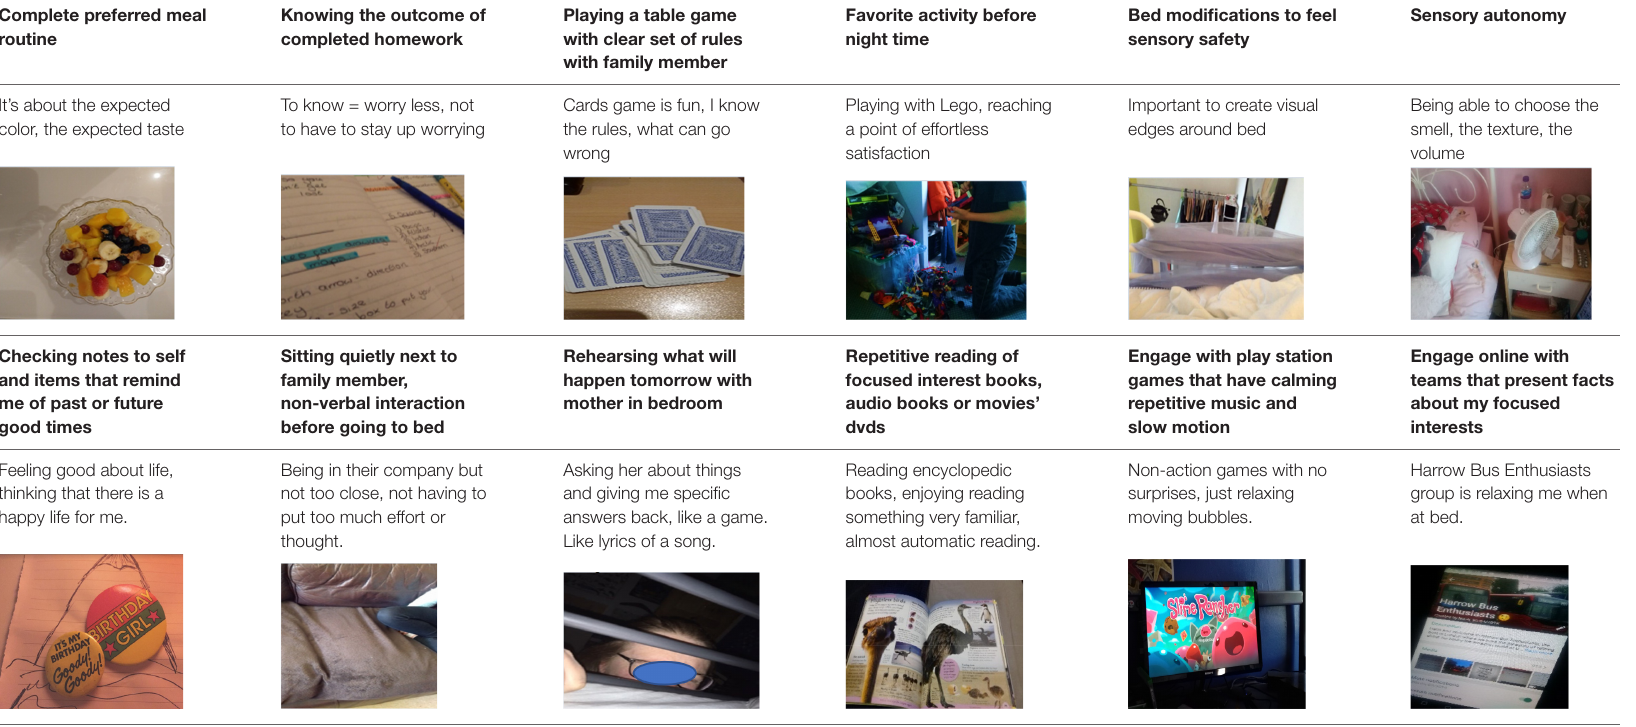
Knowing the outcome of completed homework